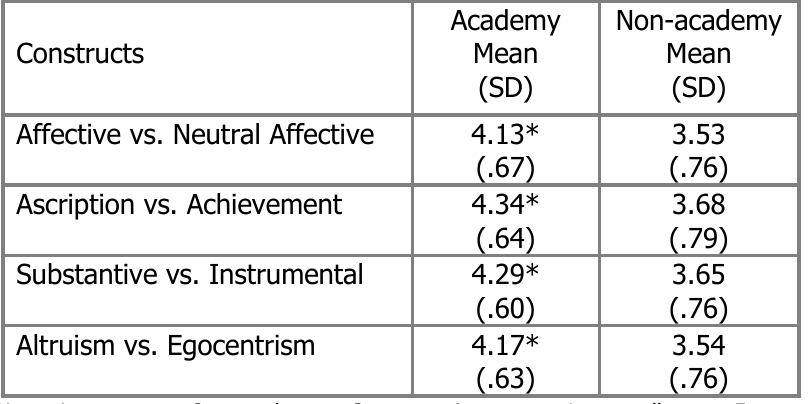
Comparison of Community Perception Means between Academy and Non-academy